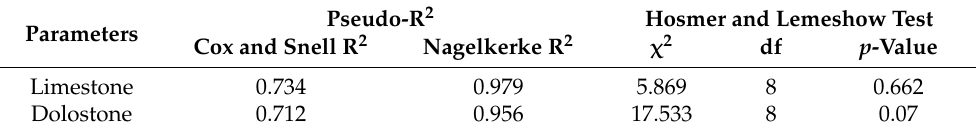
Table 4. The model summary of the BLR model in the target outcrop.